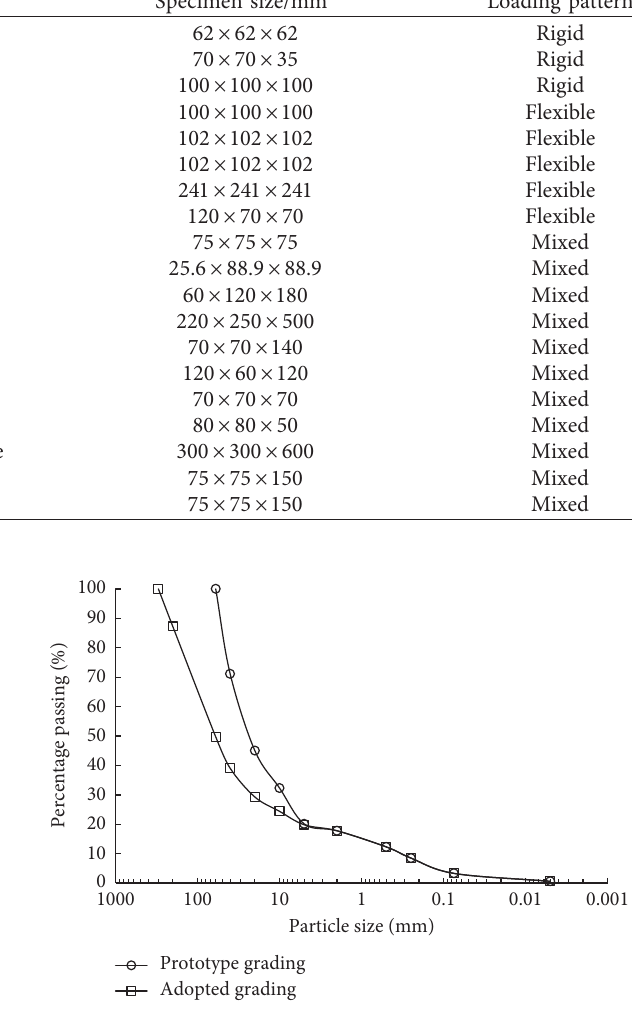
Figure 1: The prototype grading curve in the field and the adopted grading curve in laboratory.